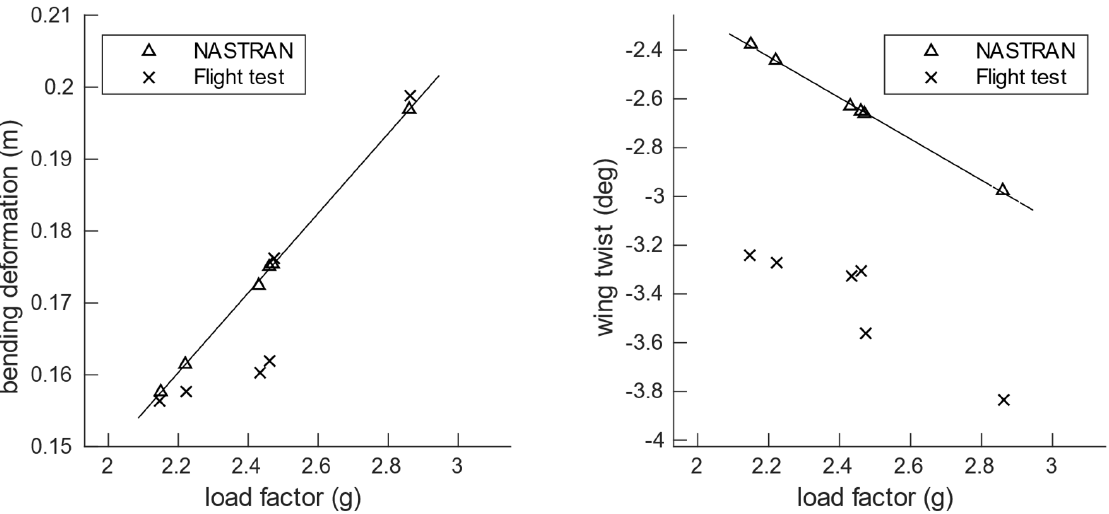
Figure 19. Bending and twist deformation (near wing tip—at spanwise location 2.95 m) at different flight test manoeuvres for the tailored wing.